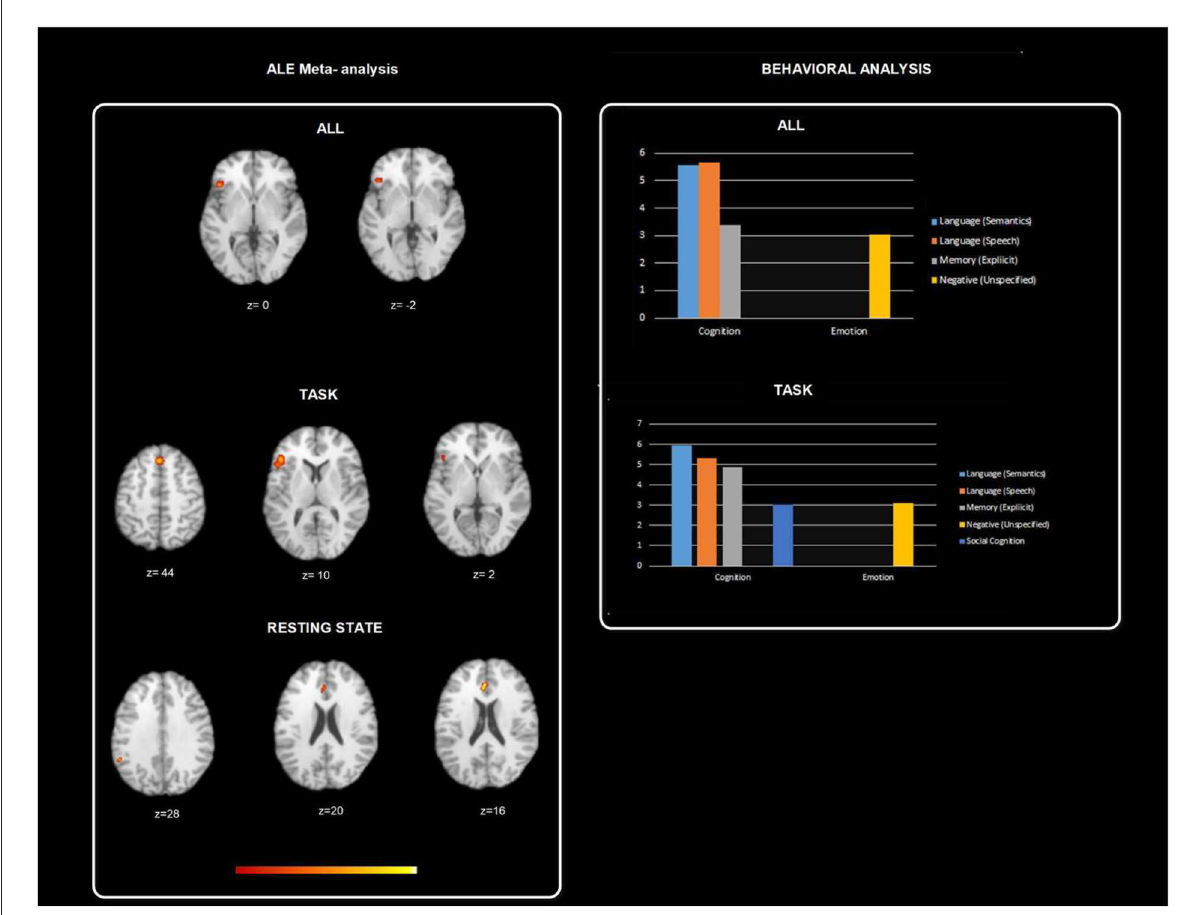
FIGURE3 Figure depicts behavioral analysis of the ALE resulting maps using Behavioral Analysis plugin of Mango v.2.6. Behavioral Analysis presented for BrainMap’s five Behavioral Domains (Action, Cognition, Emotion, Interoception, and Perception) and sixty sub-domains. Only z -scores ≥ 3.0 are considered significant ( p ≤ 0.05 with Bonferroni corr.). All psychotherapies resulted in a map that allowed significant behavioral analysis for the domain cognition (Language and Memory; z = 5.09) and emotion (Negative; z = 3.04). ALE task map did not show significant results for the above-mentioned domains. ALE resting state fMRI map showed significant results for the domain emotion (Positive reward /Gain; z = 3.236). The observed homogeneous clusters in the CBT-ALE map allowed significant cognition domain (reasoning, language, memory, and attention) and emotion domain